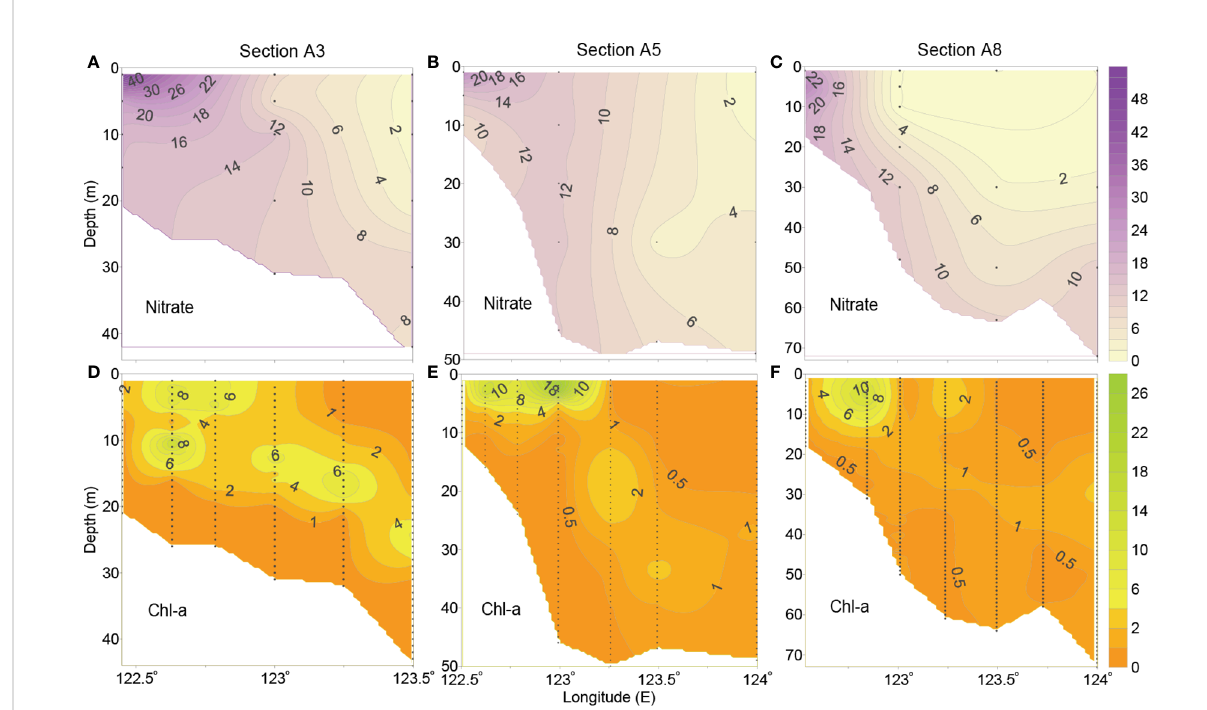
FIGURE 5 Vertical distributions of (A – C) nitrate ( m mol dm -3 ) and (D – F) Chl-a ( m g dm -3 ) along typical sections off the CE in August 2013 (the distribution patterns of phosphate and silicate are similar to that of nitrate and hence are not